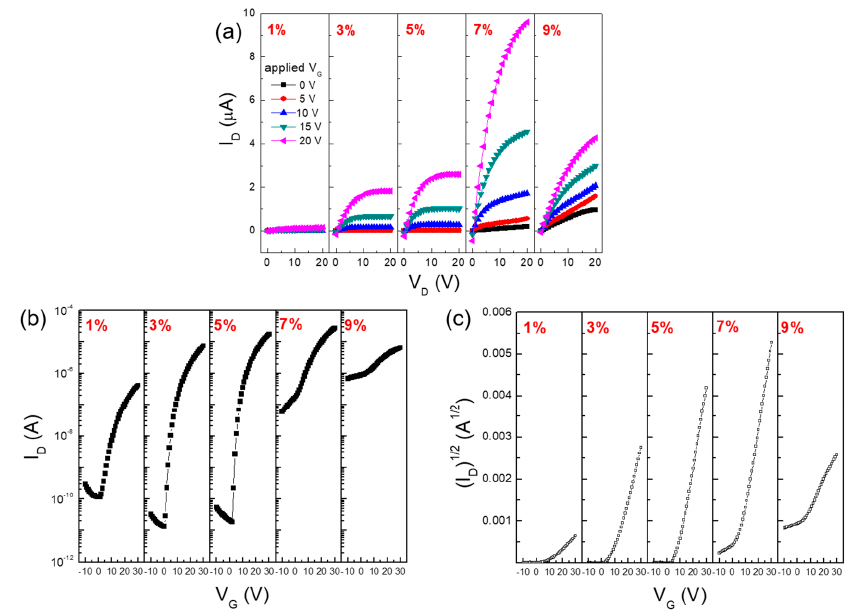
Figure 6. ( a ) I D vs. V D ; ( b ) I D vs. V G and ( c ) ( I D ) 1/2 vs. V G plots of In-doped ZnO TFTs with different In contents. Table 1. Electrical characteristics of the In-doped ZnO TFTs with different In contents. In Concentration